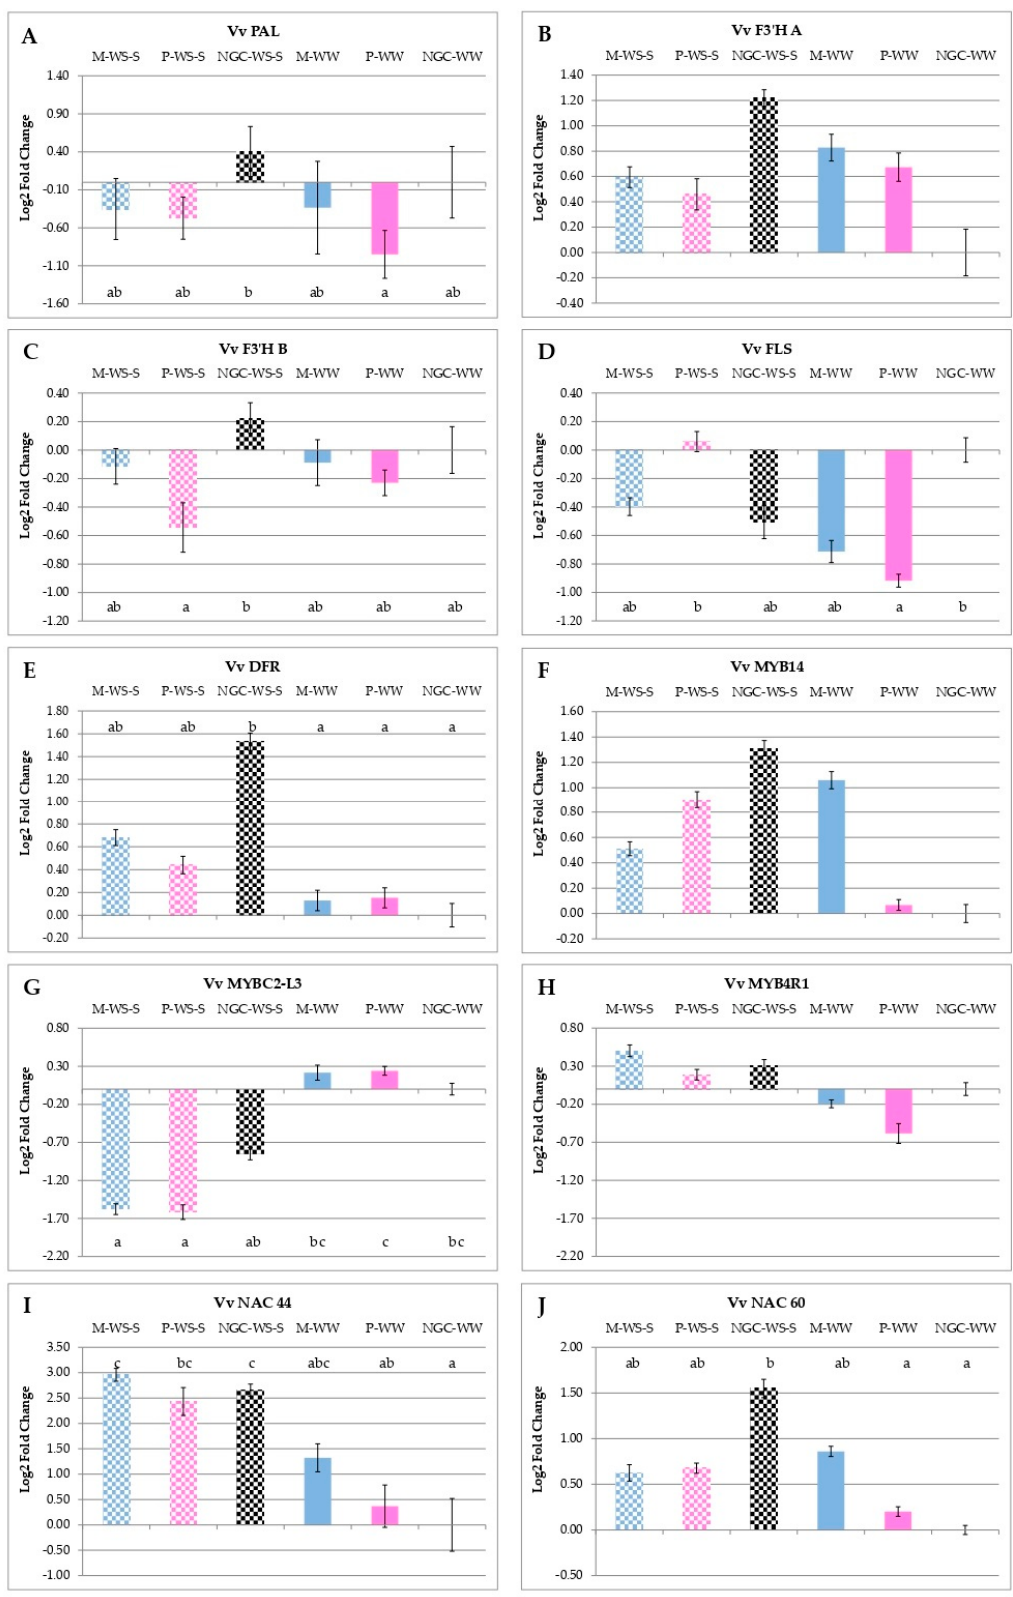
Figure 5. Expression profiles of the ten selected genes coding for structural genes and transcription factors obtained by qRT-PCR. Log2 Fold Change, calculated with the ΔΔ Ct method, of VvPAL ( A ),